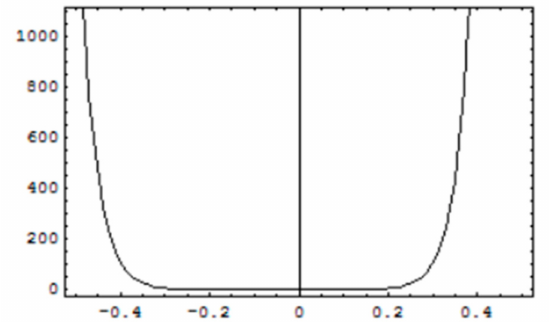
Figure 4. h -curves for solution of f (cid:48) ( 0 ) .